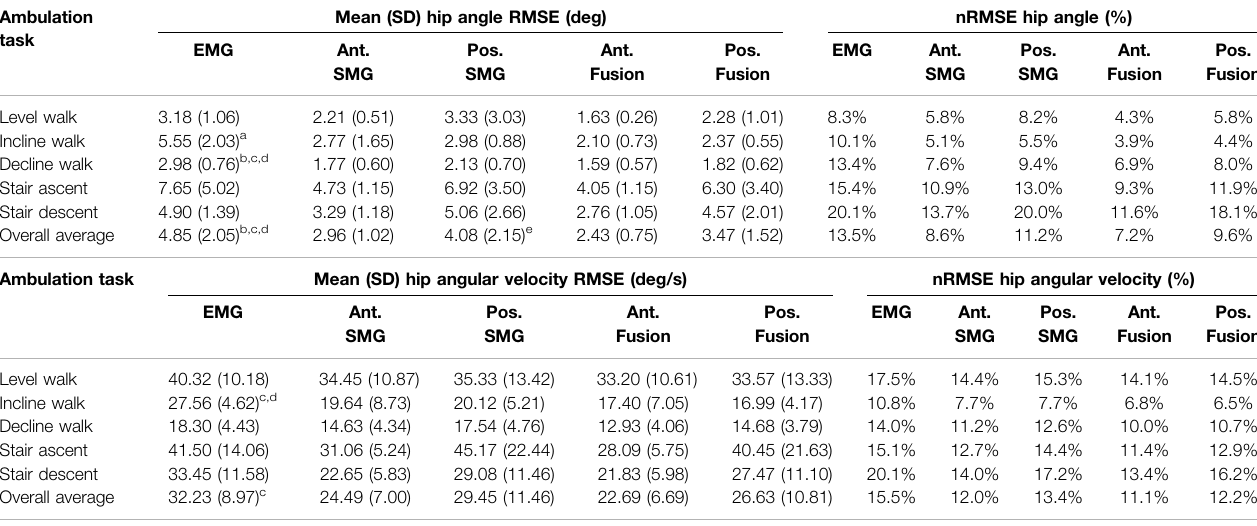
a Indicates signi fi cant difference ( p < 0.05) between RMSE, of EMG, and all other sensing modalities. b Indicates signi fi cant difference between ( p < 0.05) RMSE, of EMG, and anterior SMG. c Indicates signi fi cant difference between ( p < 0.05) RMSE, of EMG, and anterior sensor fusion (anterior SMG, with EMG). d Indicates signi fi cant difference between ( p < 0.05) RMSE, of EMG, and posterior sensor fusion (posterior SMG, with EMG). e Indicates signi fi cant difference between ( p < 0.05) RMSE, of posterior SMG, and anterior sensor fusion (anterior SMG, with